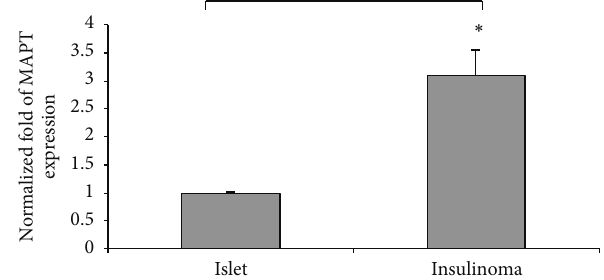
Figure 1: RT-qPCR of RNA isolated from human islets and human insulinomas. Expression of MAPT gene level evaluated in human islets ( 𝑛 = 3 ) and in human pancreatic insulinomas ( 𝑛 = 5 ); 𝑝 < 0.01